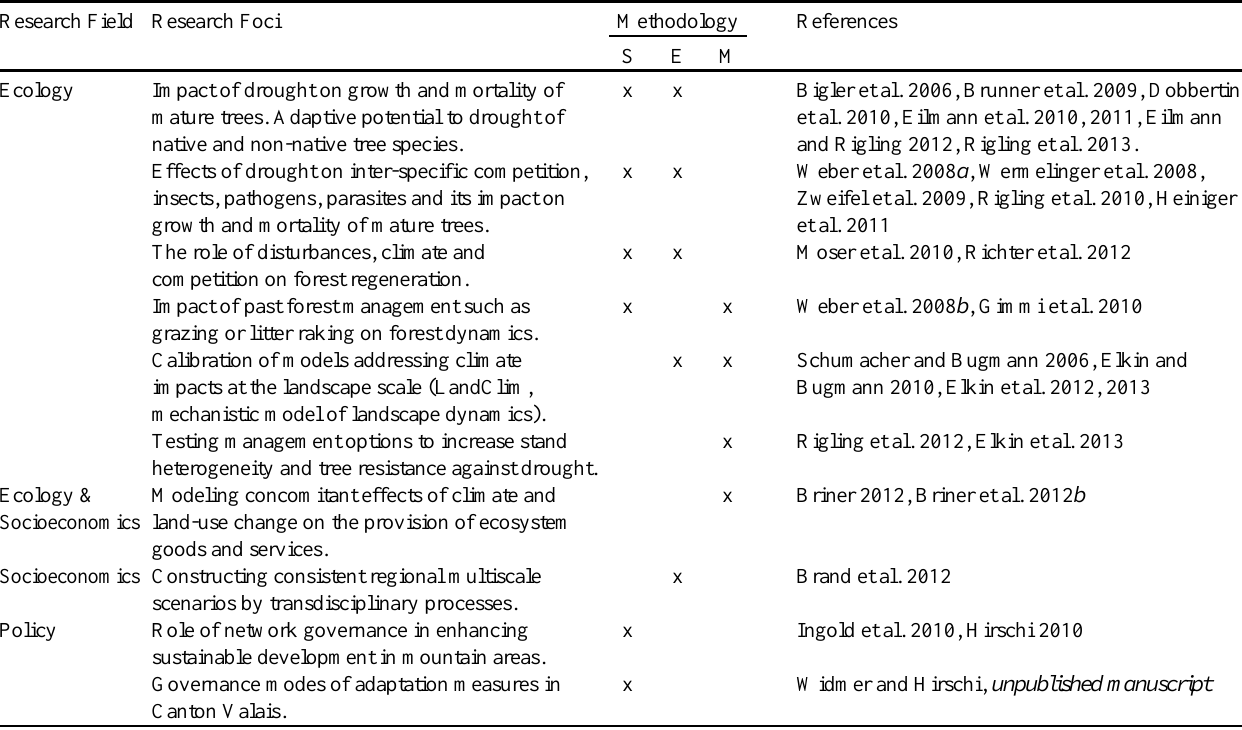
Table 2 . Research foci and methodologies in the dry alpine region